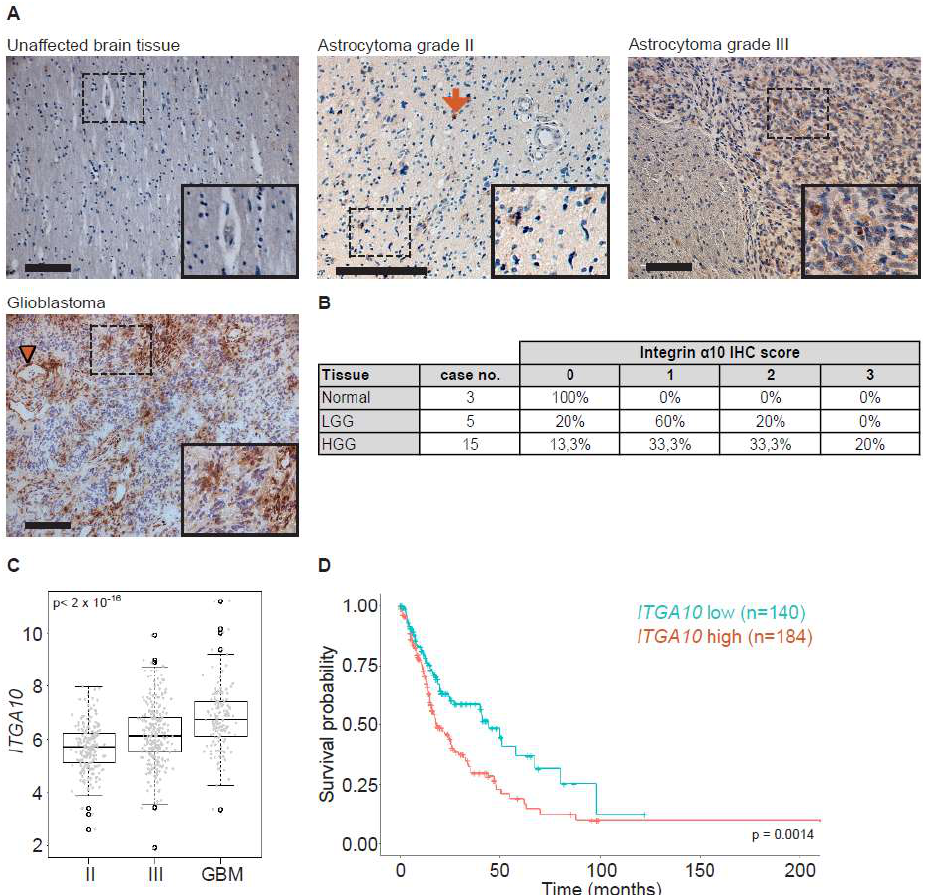
Figure 1. Integrin α 10 is expressed in human glioma tissue. ( A ) Immunohistochemical evaluation of integrin α 10 expression (brown) in morphologically benign brain tissue and in tumors defined as human astrocytoma grades II and III and glioblastoma (GBM) specimens using a polyclonal antibody directed against the cytoplasmic tail of integrin α 10. The arrow indicates integrin α 10-positive cells in astrocytoma grade II tissue, and the arrowhead in GBM tissue indicates α 10 expression surrounding a blood vessel. Scale bars represent 100 µ m in una ff ected brain tissue and in grade III tissue, 200 µ m in grade II tissue, and 50 µ m in GBM tissue. Boxed areas are shown at a higher magnification in the lower right images. Immunohistochemical scoring of labeling intensities for integrin α 10-immunoreactive cells in normal and glioma [low-grade (LGG) and high-grade (HGG)] tissue is summarized in panel ( B ). Scoring of the labeling intensity of the tissues was 0 (negative), 1 (weak), 2 (moderate), and 3 (strong). ( C ) Normalized TCGA (The Cancer Genome Atlas) gene expression data (IlluminaHiSeq, San Diego, CA, USA) for low-grade gliomas and GBM, and clinical information on the grade of low-grade gliomas was used to stratify patients into astrocytoma grades II and III, and GBM. All statistical analyses were performed using one-way ANOVA and the non-parametric alternative (Kruskal–Wallis test). A statistically significant di ff erence was found between the three groups ( p -value < 2 × 10 − 16 ). ( D ) Kaplan–Meier curve comparing the overall survival probability of glioma patients (astrocytoma grade II, n = 59; astrocytoma grade III, n = 116; and GBM n = 149) with low vs. high ITGA10